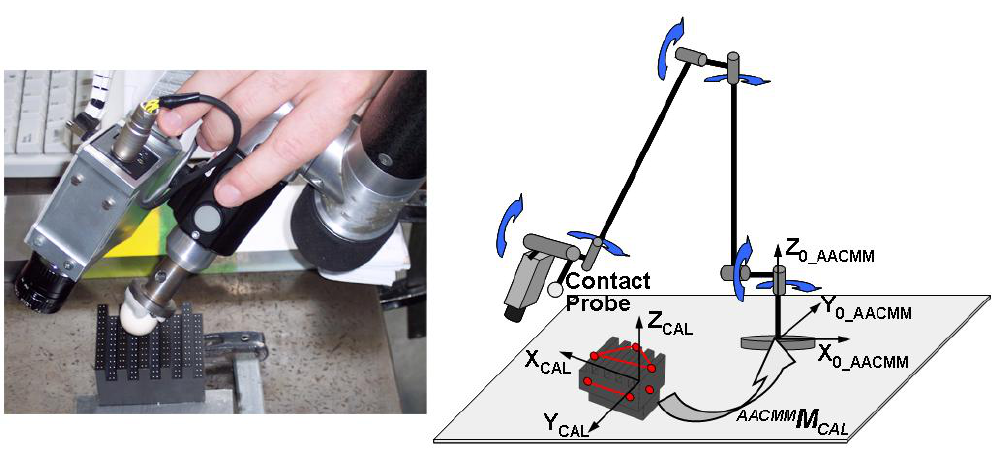
Figure 7. Gauge object contact measurement. Alignment of AACMM and calibration object coordinate